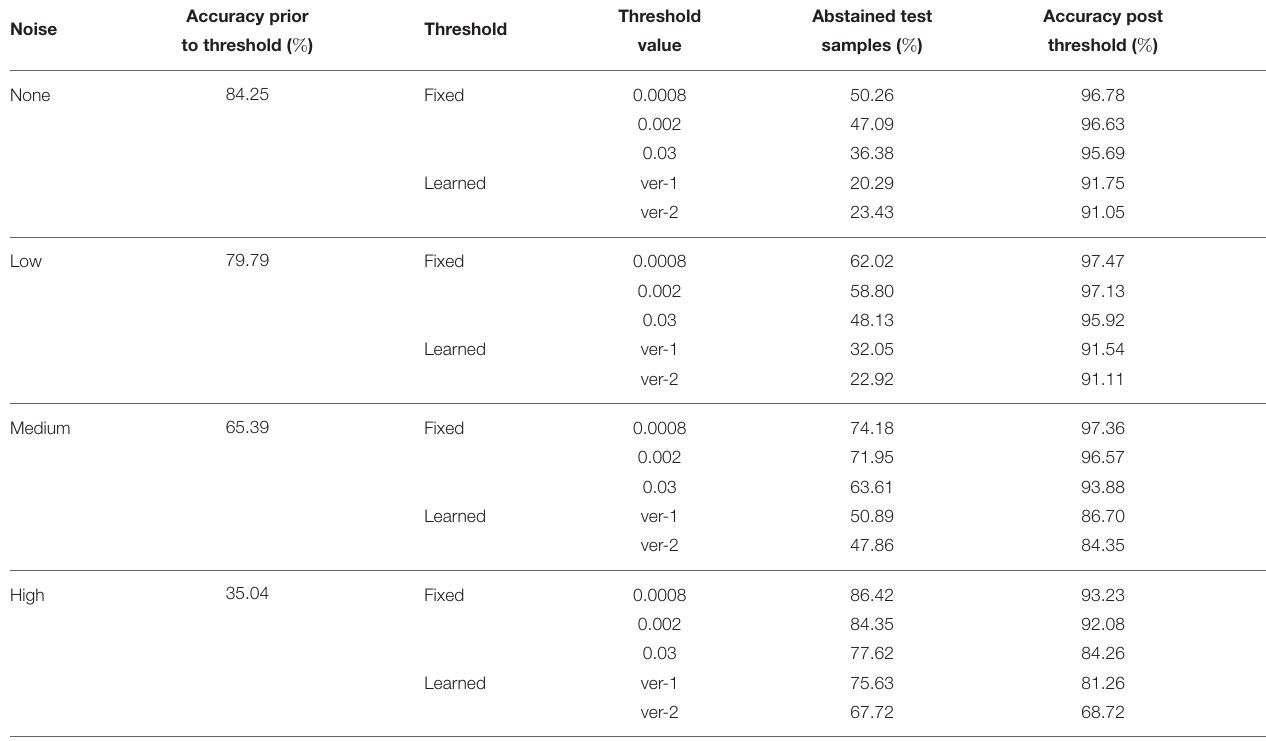
TABLE 5 | Detection of failure in BDNNs—PathMNIST dataset tested under various levels of Gaussian noise.